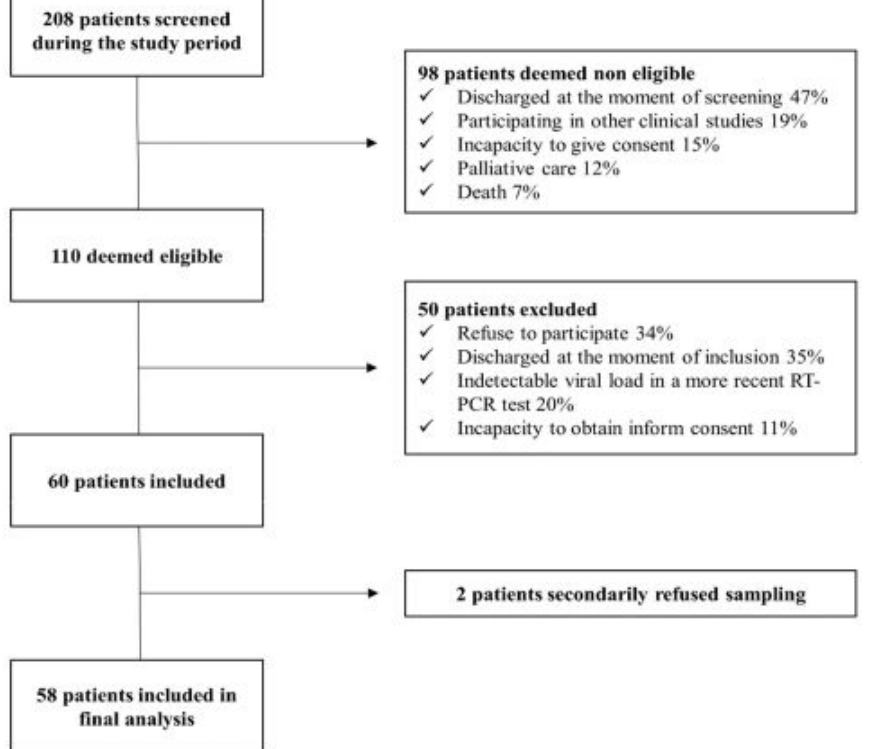
Figure 1. Flowchart of screening